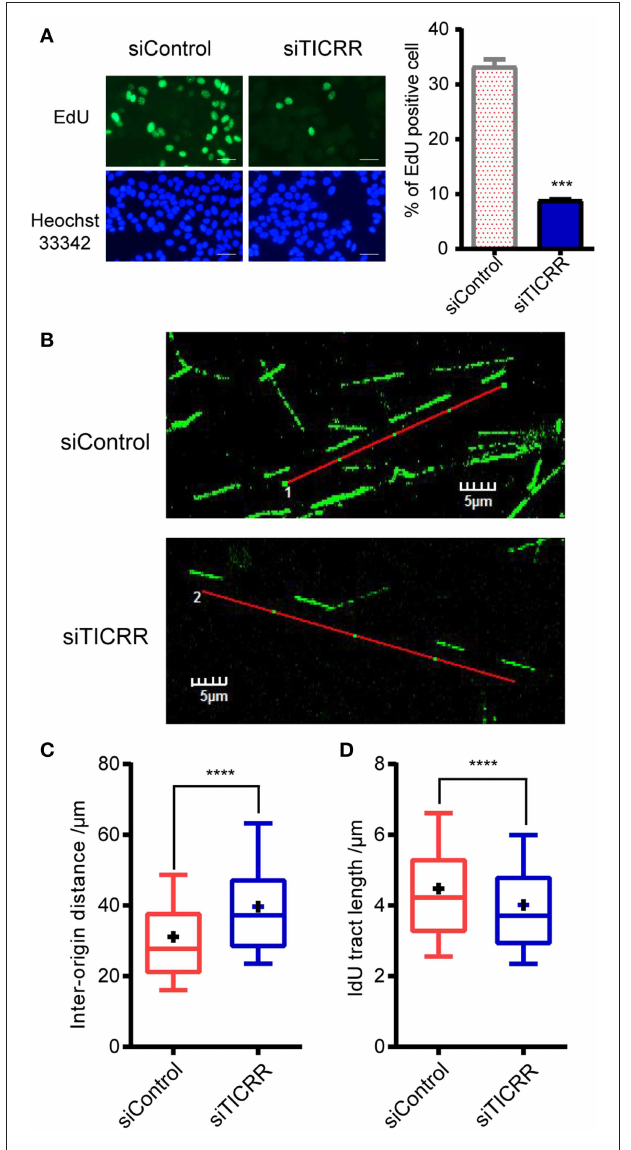
FIGURE 4 | Knockdown of TICRR significantly inhibited DNA replication. (A) Schematic representation of EdU labeling in MCF7 cells with or without knockdown of TICRR . DNA was visualized by Hoechst 33342 staining. Scale bar = 50 µ m. The percentage of EdU-positive cells was shown on the right. *** p -value < 1.00 × 10 − 3 two-tailed Student’s t -test. N = 2 biological replicates. (B–D) DNA fiber assay in MCF7 cells after transfection of siTICRR and control siRNA. The image of typical DNA fibers was shown in (B) . Scale bar = 5 µ m. The quantification and the densities of inter-origin distance (IOD) and IdU-labeled tract length were shown in (C) and (D) . Whiskers indicate 10 and 19th percentiles and center values depict the median and plus depict the mean. **** p < 1.00 × 10 − 4 , determined by two-tailed Welch’s t -test. Experiment number was shown in Table S3 .